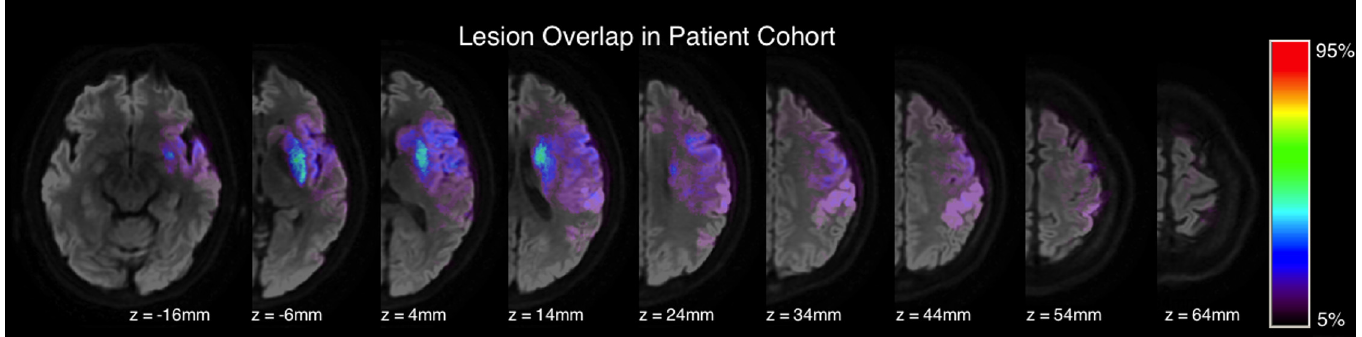
Fig 2. Infarct probability map of the patient cohort. Infarct probability map overlaid on a diffusion-weighted volume of a selected patient. Color map corresponds to the percentage of patients with infarcted tissue in a given voxel. Z-coordinates are in MNI